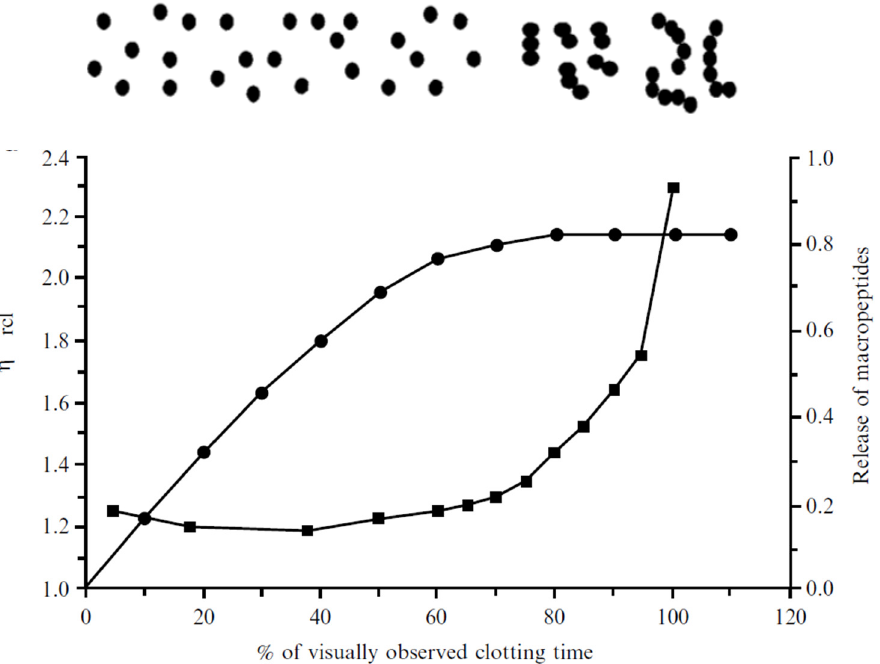
Figure 3. Release of macropeptides, expressed as fraction ( ● ).Changes in relative viscosity ( ■ ) dur- ing the course of rennet coagulation. On top of the figure, casein micelle aggregation progress is graphically represented. Reproduced with permission from [Chen, C.-C.; Chen, L.-Y.; Li, W.-T.; Chang, K.-L.; Kuo, M.-I.; Chen, C.-J.; Hsieh, J.-F], [Influence of Chymosin on Physicochemical and Hydrolysis Characteristics of Casein Micelles and Individual Caseins.]; published by [ Nanomateri- als ], [2021].